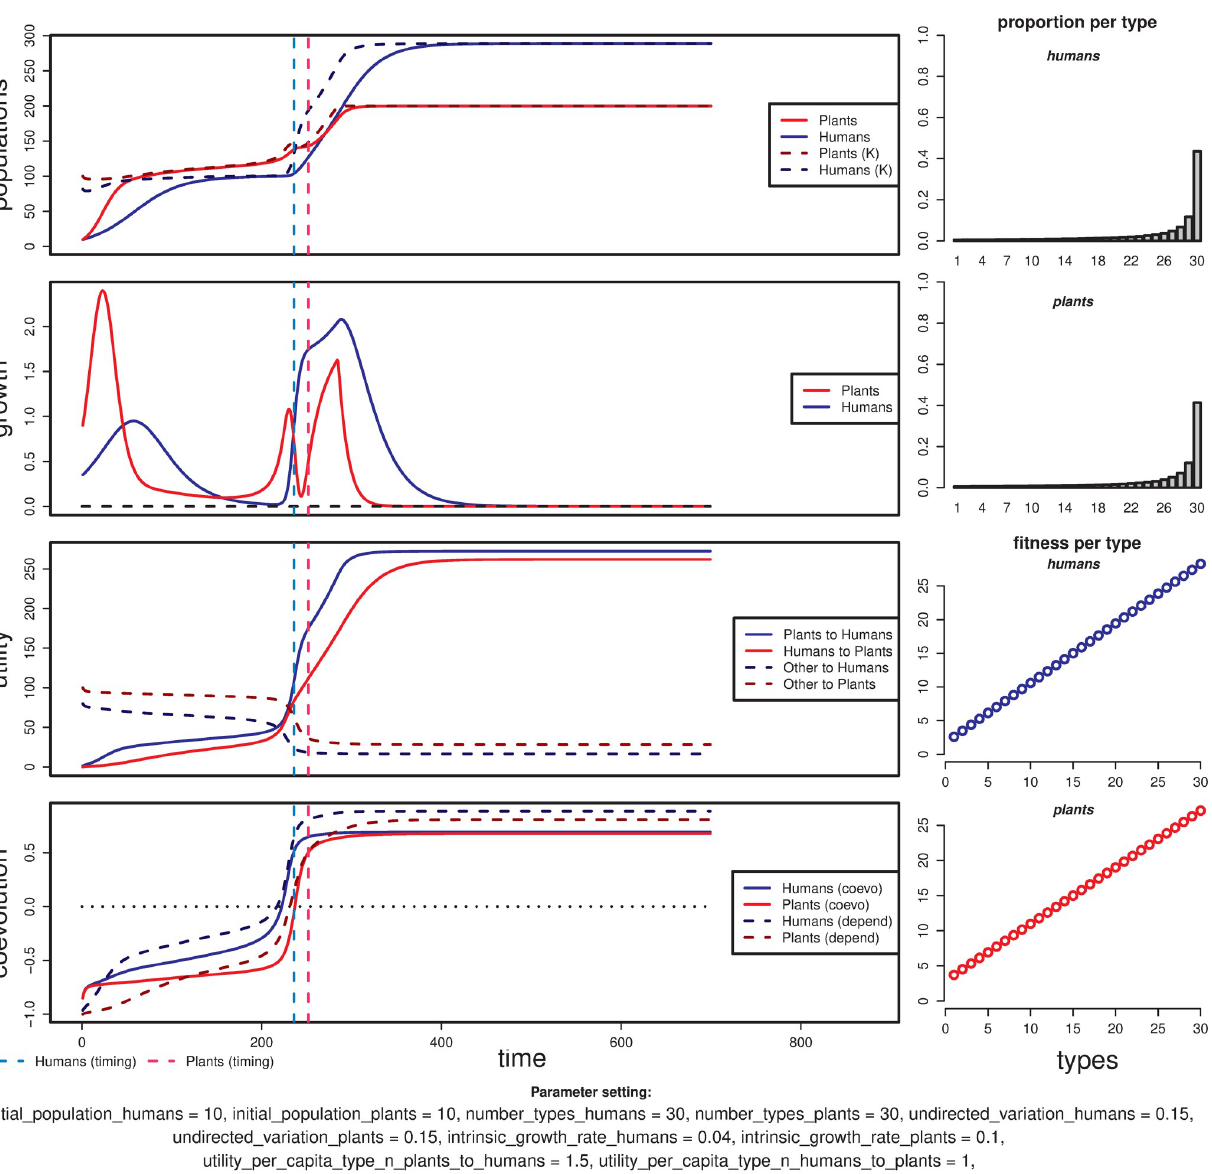
Fig 5. Example of a simulation run with a case of successful coevolution where human and plant populations change roughly at the same time. Vertical dashed lines mark the timing of change for humans (cyan) and plants (pink). This parameter setting was taken as the default in the R implementation of the